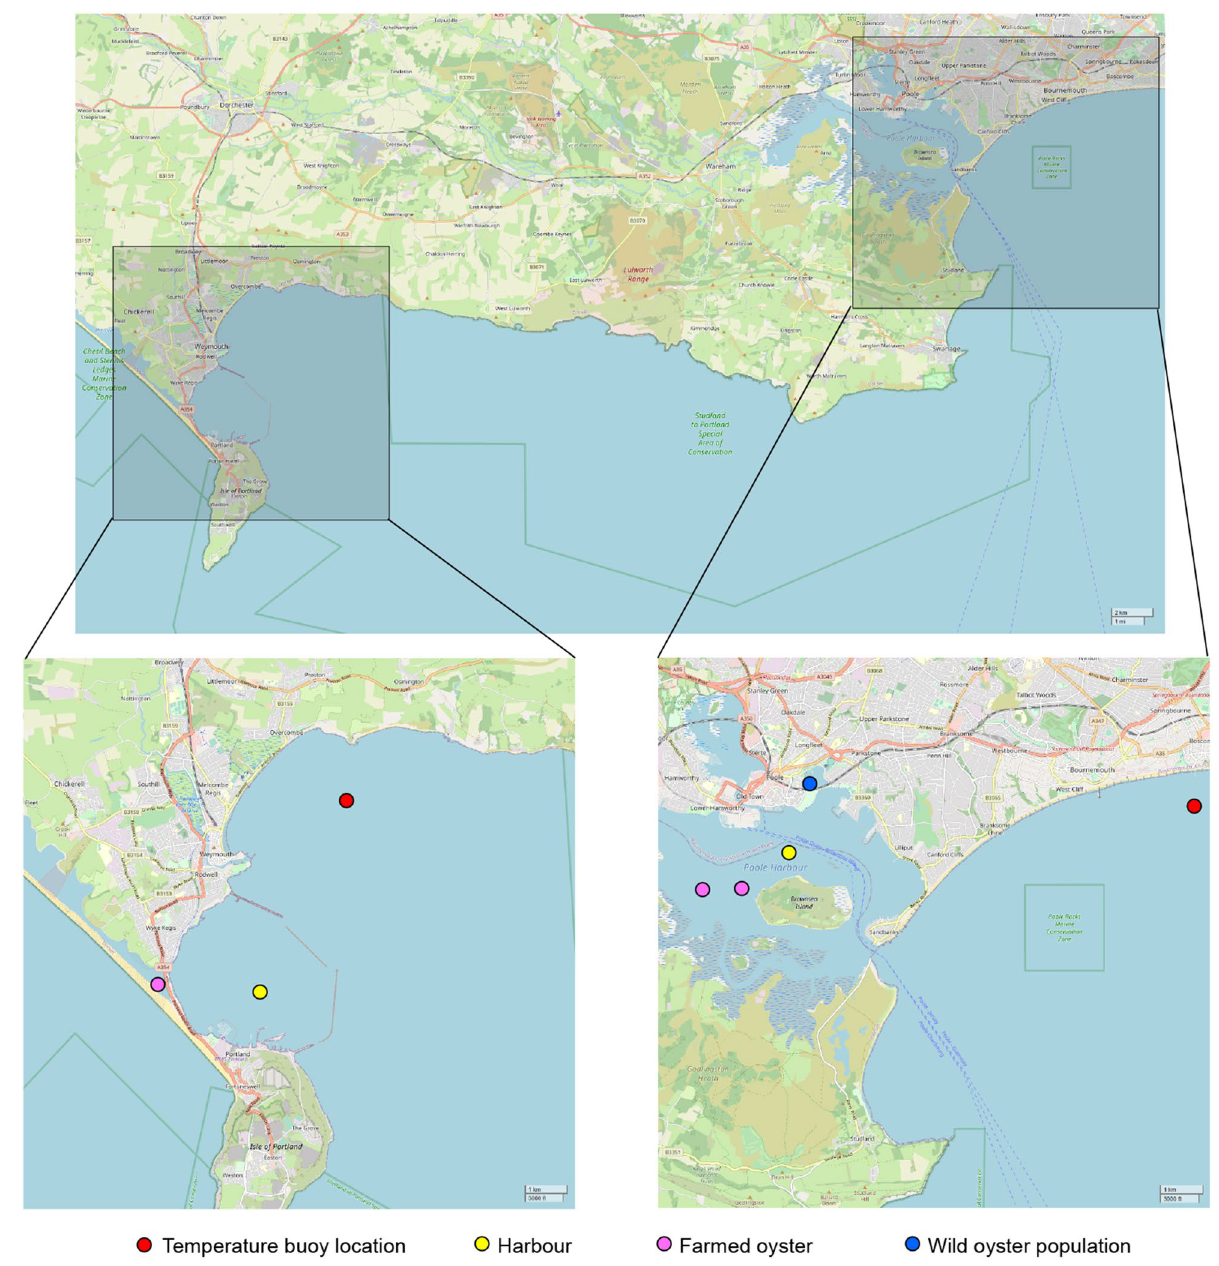
Figure 8. Location of Weymouth (left) and Poole (right) with temperature buoy location (red circle), harbor (yellow circle), farmed oyster (purple circle) and established wild oyster population (blue circle), created using Inkscape 0.91 69 and OpenStreetMap (copyright OpenStreetMap contributors, licensed under the Open Data Commons Open Database License (ODbL) by the OpenStreetMap Foundation (OSMF), cartography licensed as CC